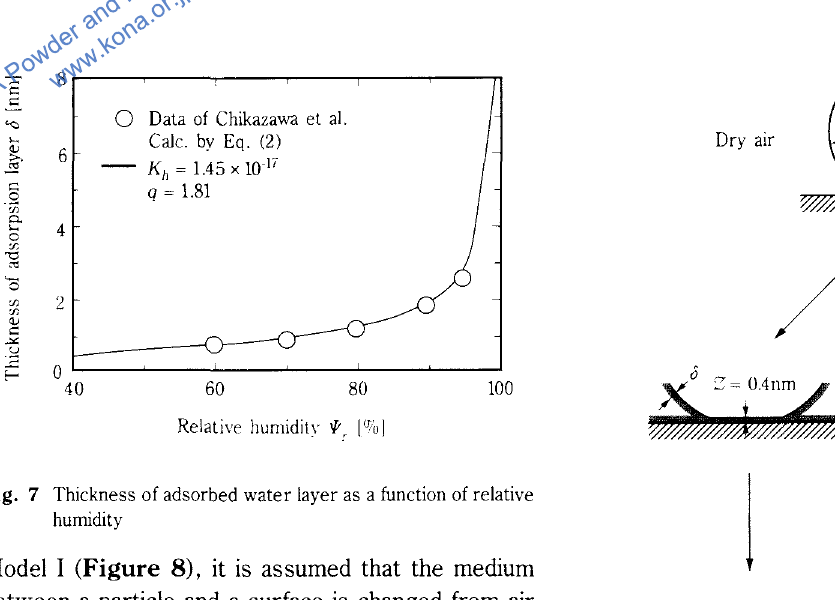
Fig. 7 Thickness of adsorbed water layer as a function of relative humidity